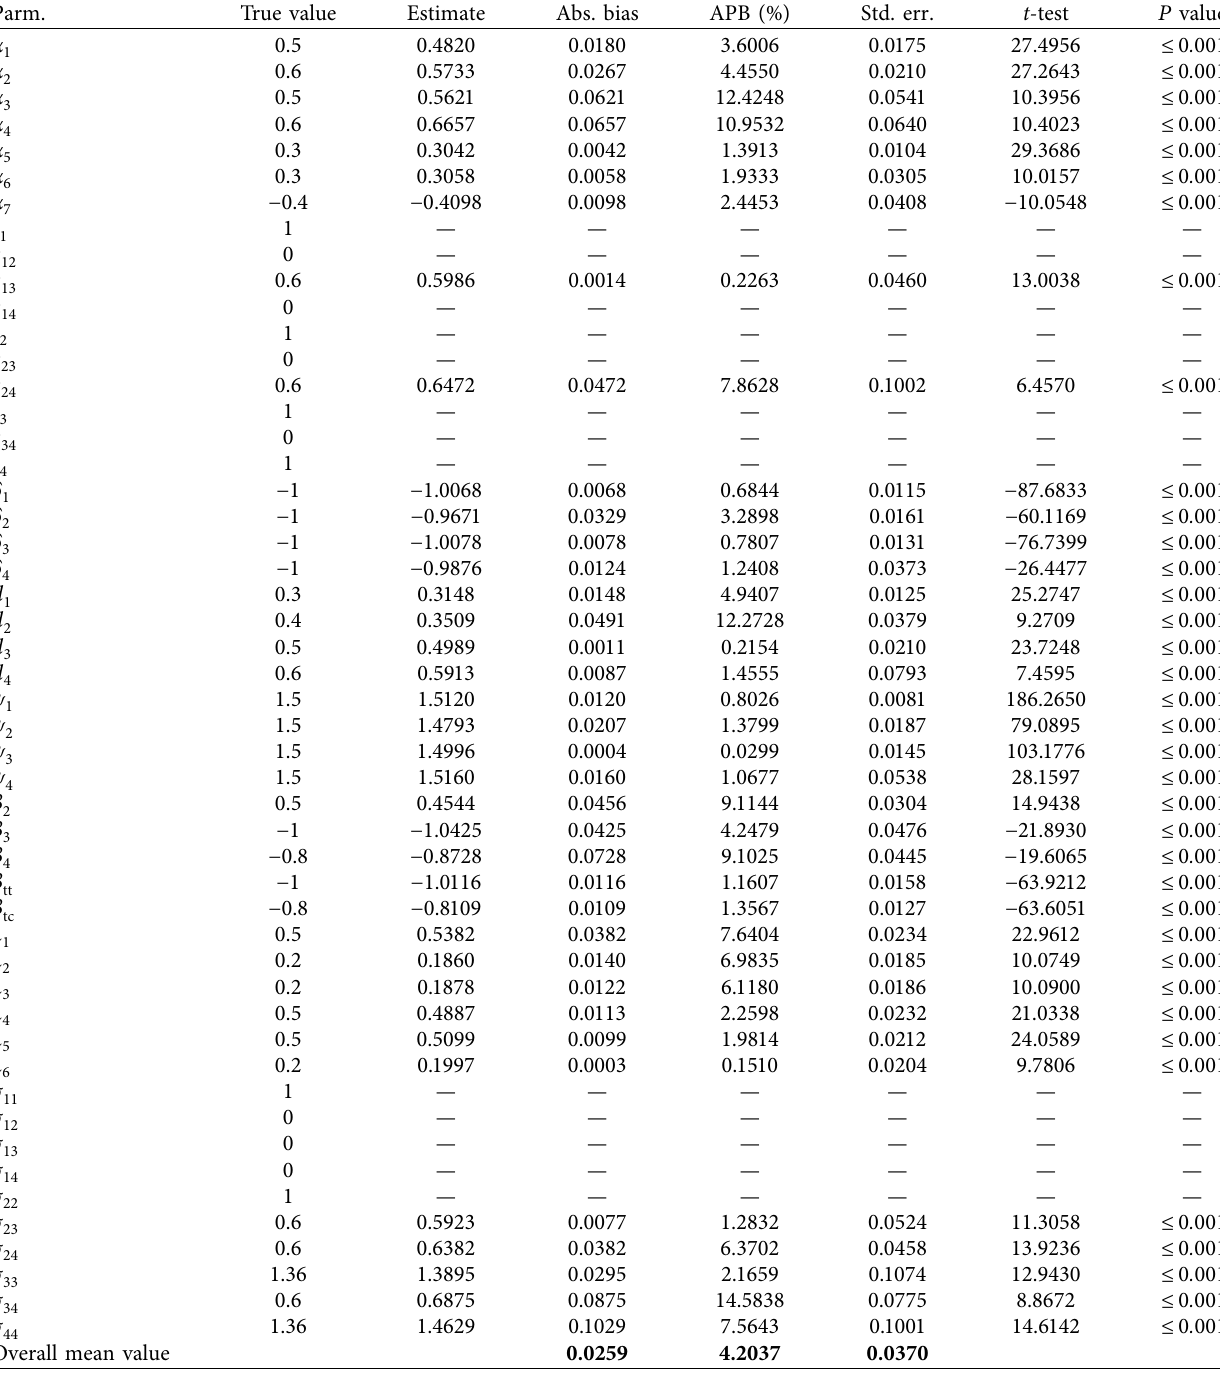
Table 6: Simulation results for the four-alternative ICLV model with the TVBS method.